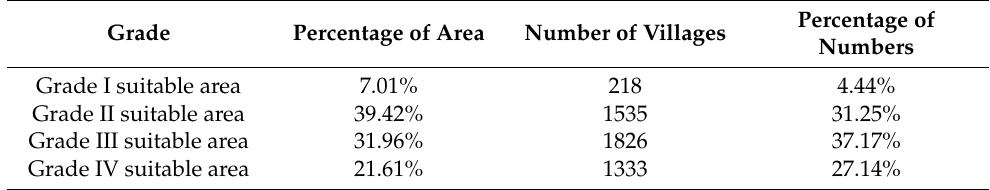
Table 4. Statistical results of suitability classification of the rural residential areas in